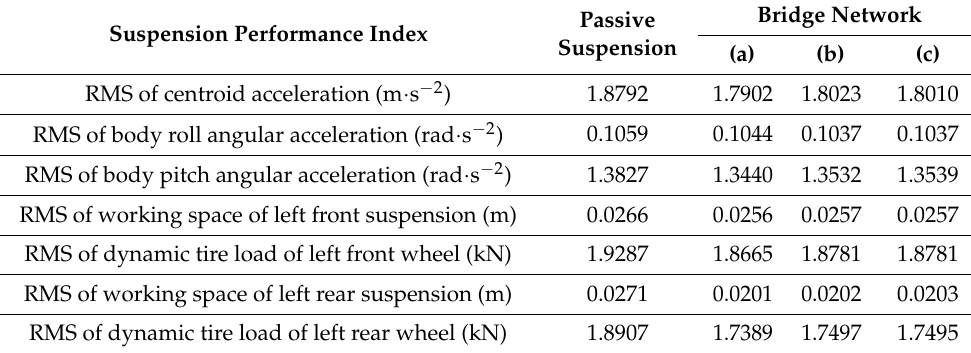
Table 3. RMS comparison of mechatronic inertial suspension based on the bridge network. Suspension Performance Index